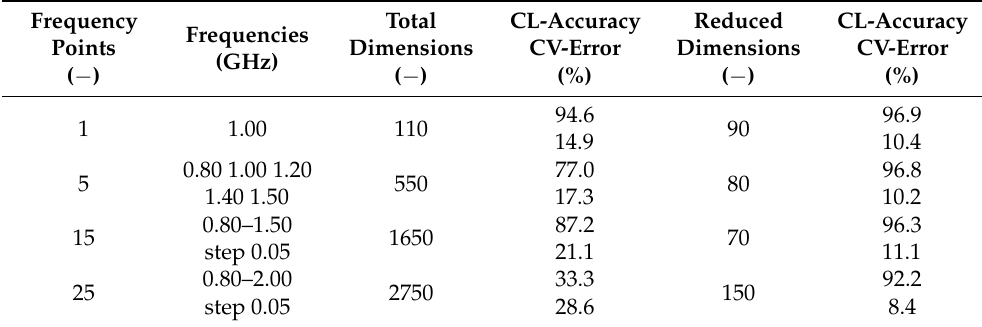
Table 8. The effect of number of frequency points and dimension reduction on the classification accuracy.